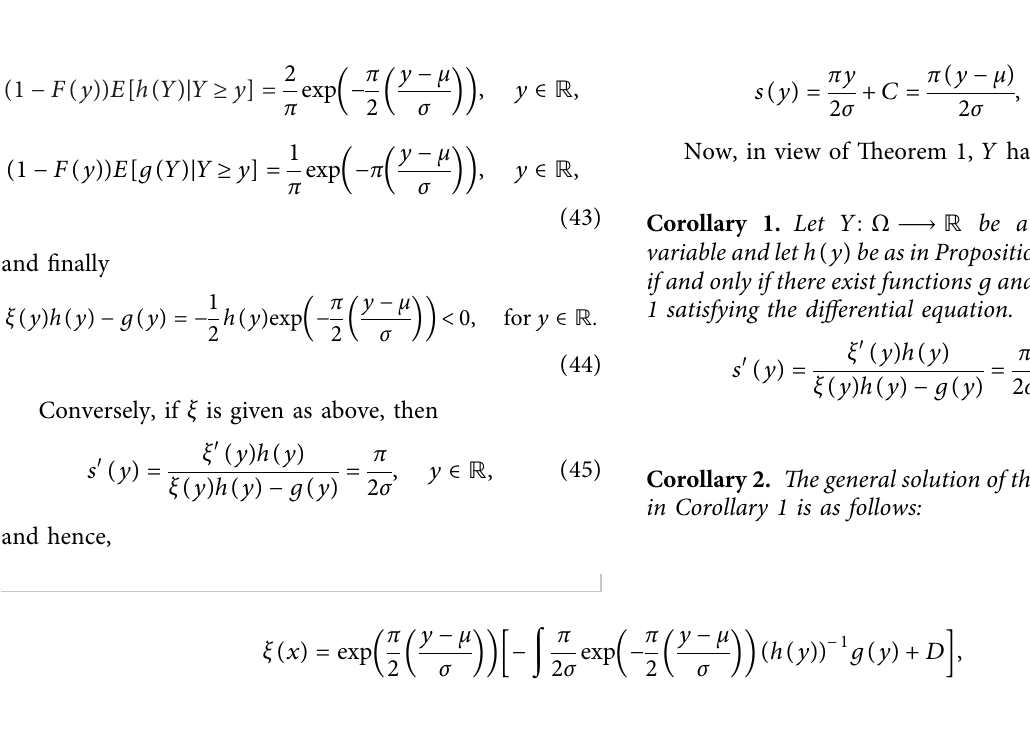
Figure 3: Existence and uniqueness of the AMLE